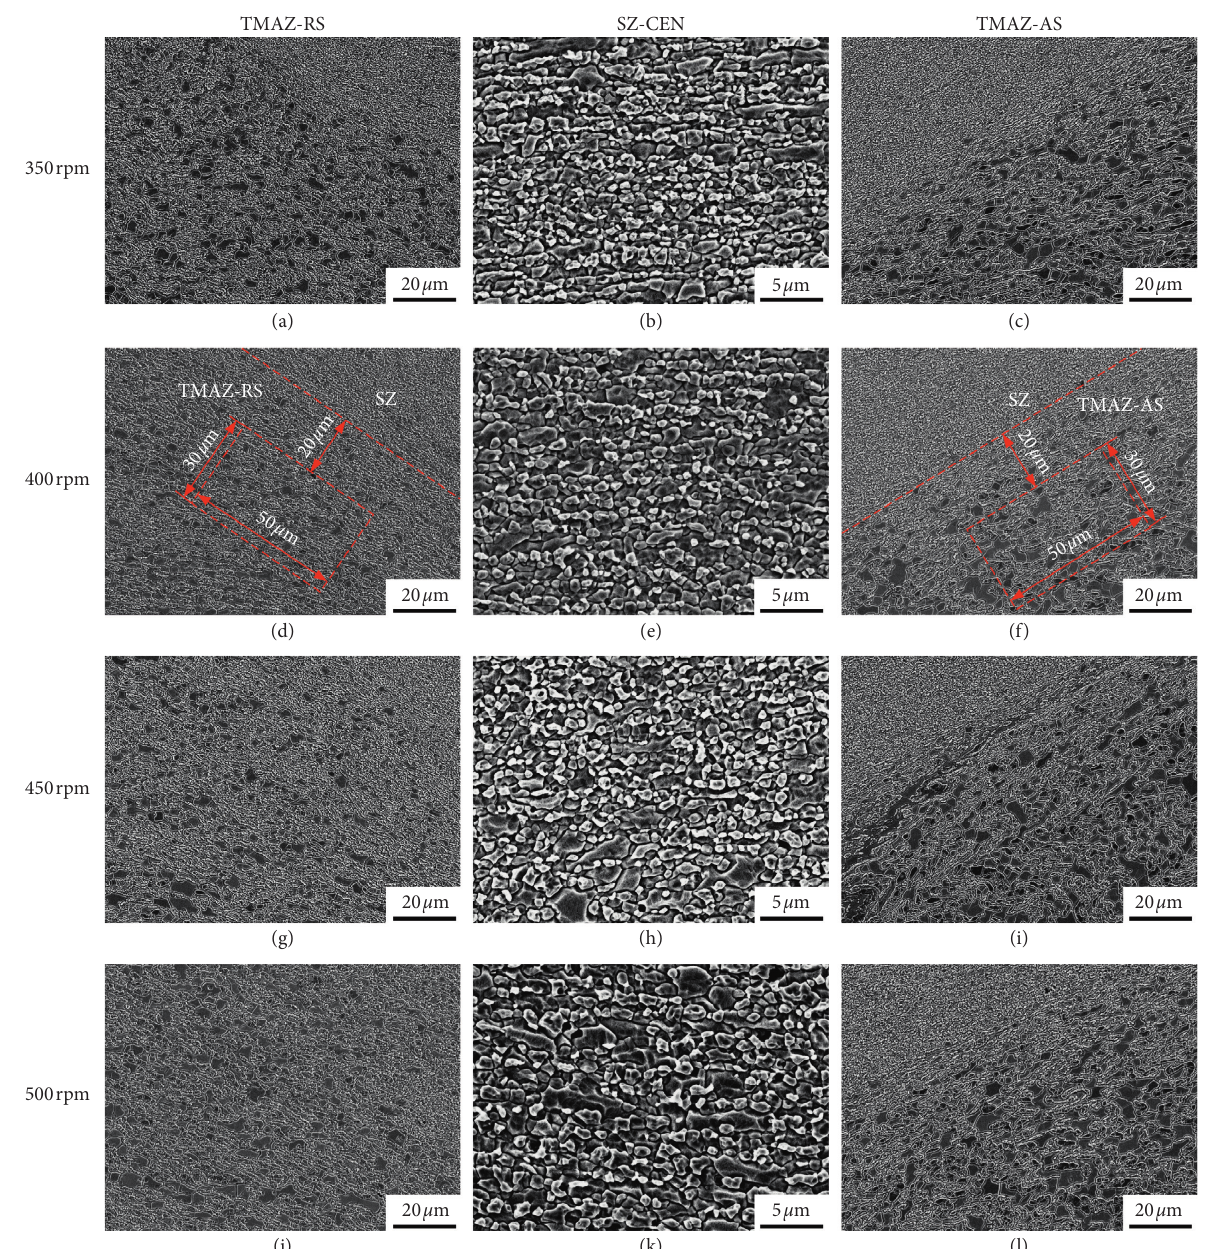
Figure 9: SEM images in TMAZ and SZ of the joints welded at various rotation speeds (electroetched with oxalic acid